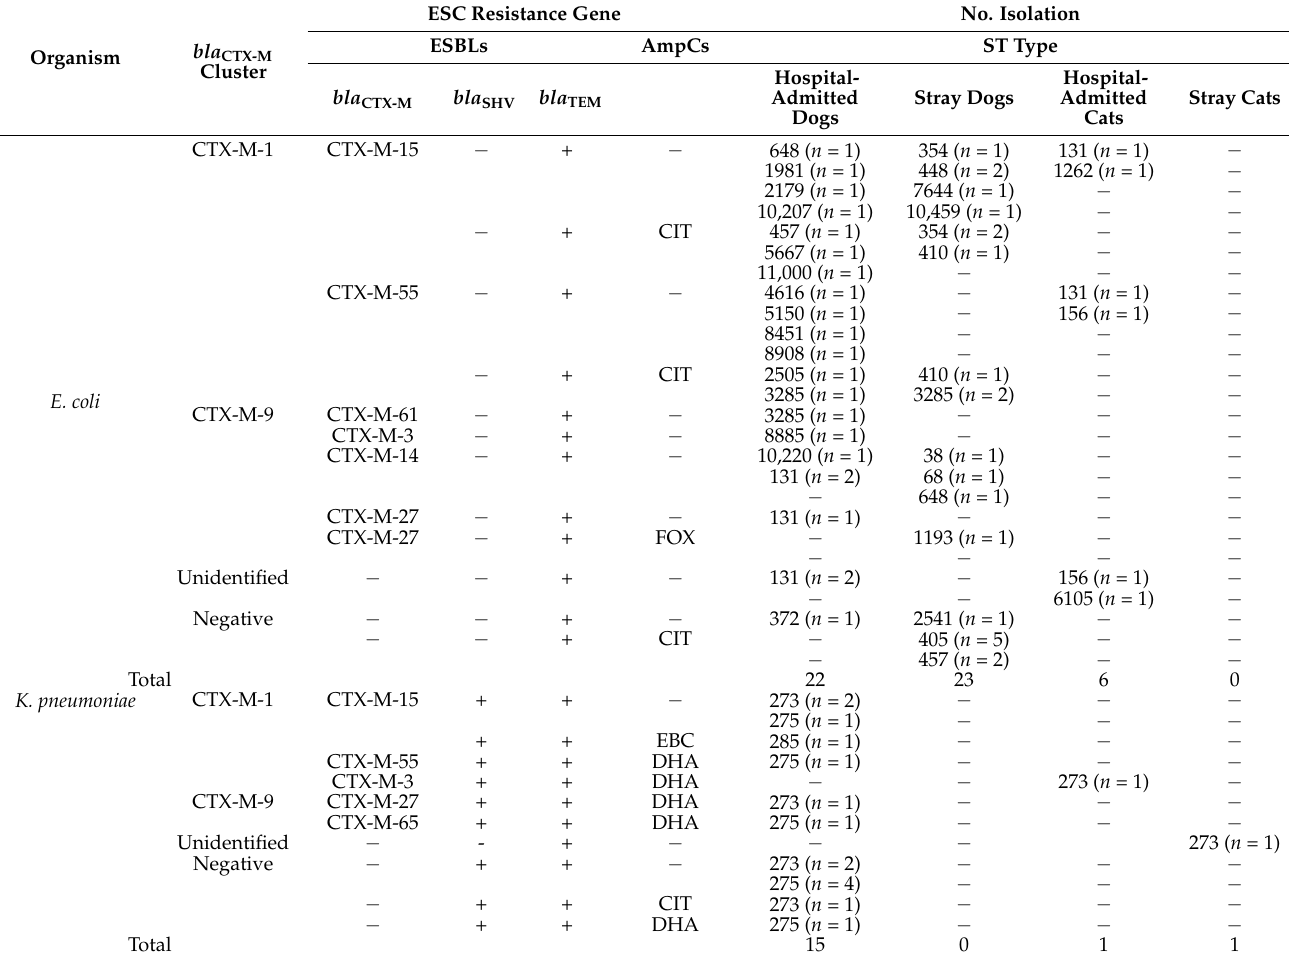
Table 4. Multi-locus sequence typing (MLST) results based on the spread of β -lactamase resistance genes.